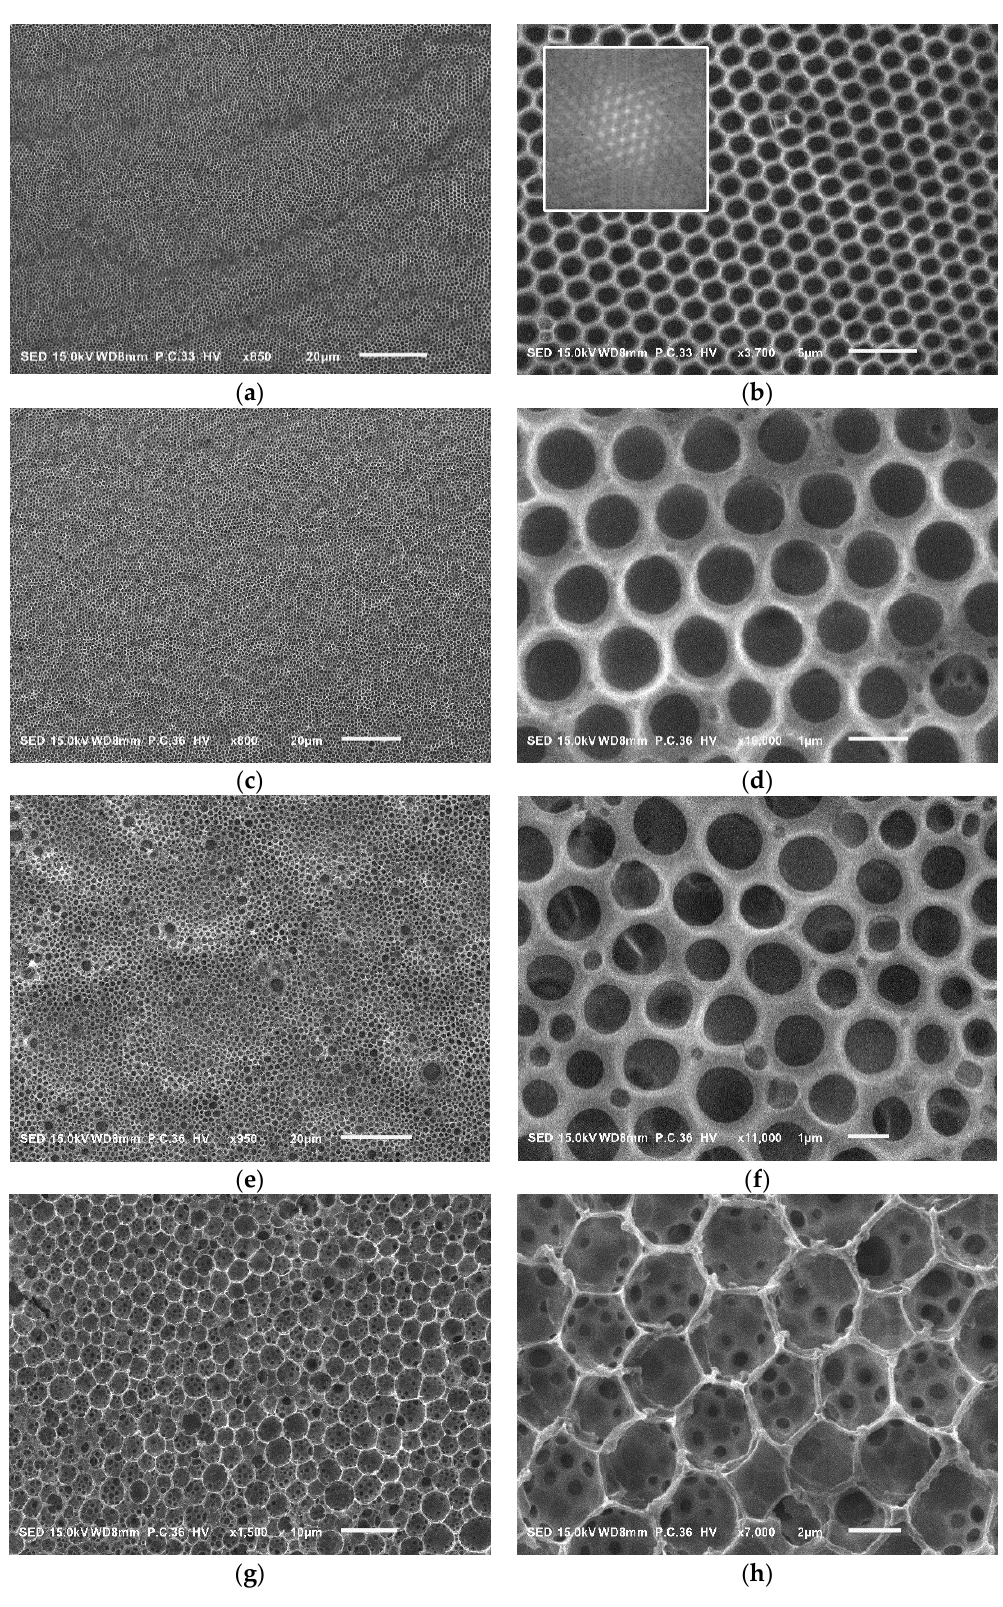
Figure 4. SEM images of BF films prepared from third-generation LDBCs with acetonide end groups: ( a , b ) LG3-PSt 68k, FFT - insert in image ( b ); ( c , d ) LG3-PSt 30k; ( e , f ) LG3-PSt 20k - majority portion of the film; ( g , h ) edge of LG3-PSt 20k film. Scale bars: ( a , c , e ) 20 μ m; ( g ) 10 μ m; ( b ) 5 μ m; ( h ) 2 μ m; ( d , f ) 1 μ m.